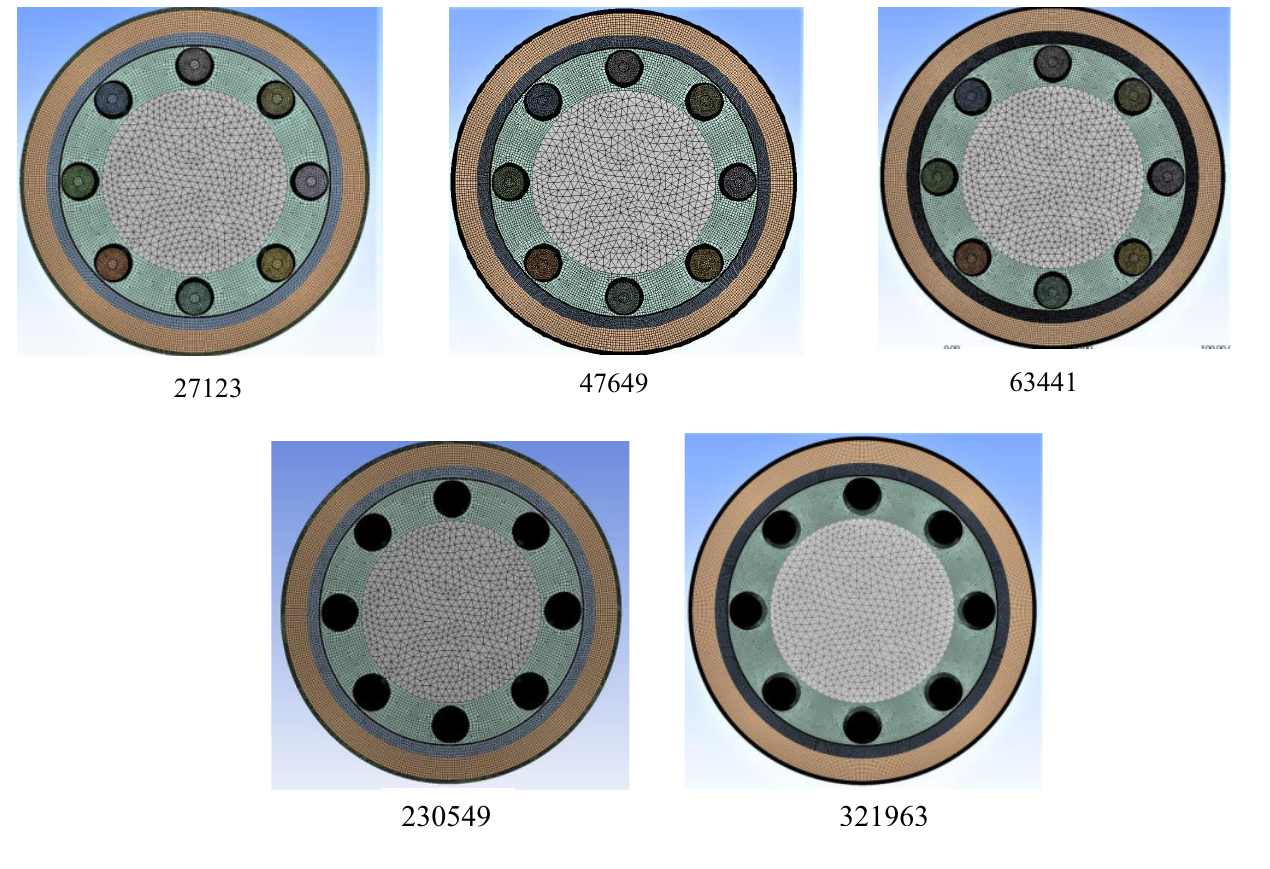
Figure 5. Different grid sizes of mesh Table II: Comparison of temperature for different mesh size (3 % decay